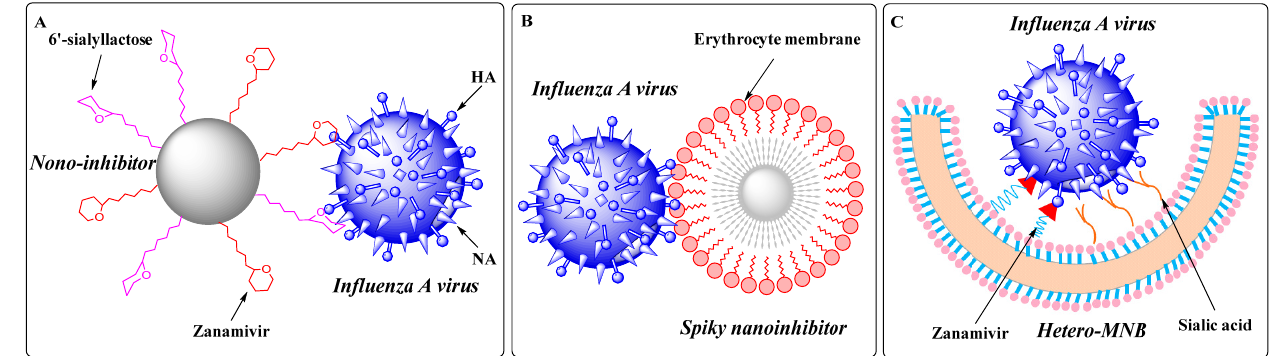
Figure 6. ( A ) Proposed binding patterns between nano-inhibitor and IAV particles [29]; ( B ) proposed binding patterns between spiky nanoparticle-based inhibitor and IAV particles [30]; ( C ) proposed binding patterns between IAV and the heteromultivalent nanobowl (Hetero-MNB), where sialic acid and zanamivir bind to HA and NA, respectively, and the bowl shape facilitating the capping to the surface of the virus particle